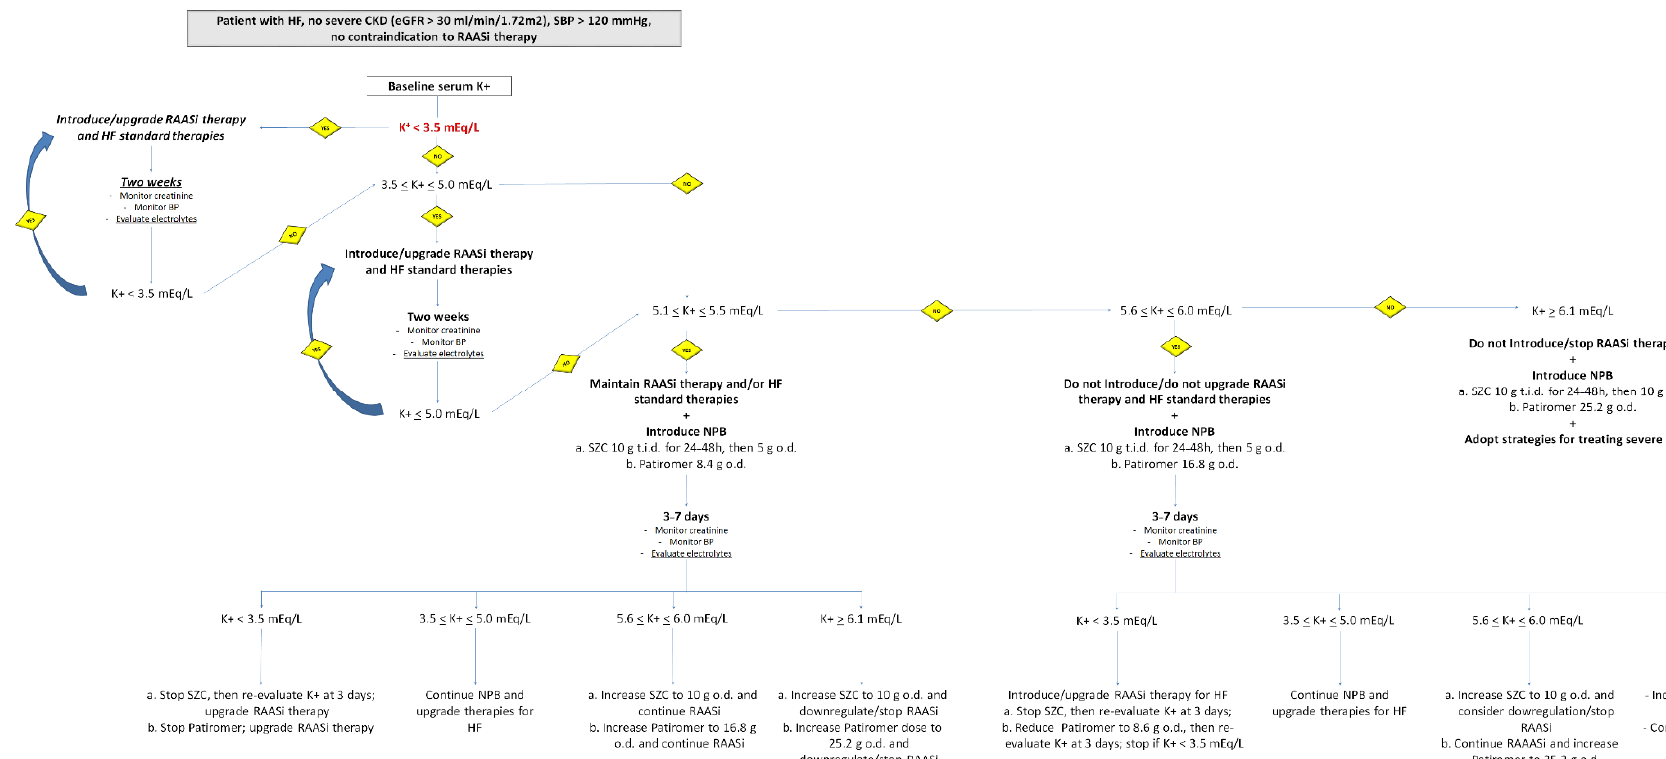
Figure 2. Proposed flow chart for the implementation of renin–angiotensin–aldosterone system inhibitors (RAASi) in patients with heart failure (HF), with no severe chronic kidney diseases (estimated glomerular filtration rate (eGFR) > 30 mL/min/m 2 ) and hyperkalemia (serum K+ > 5.1 mEq/L).